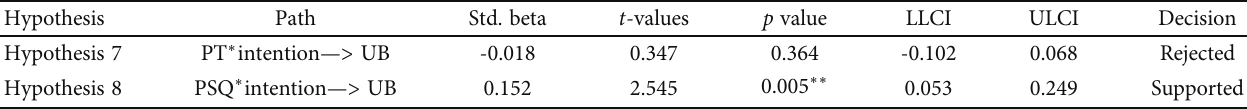
Table 6: Moderation test